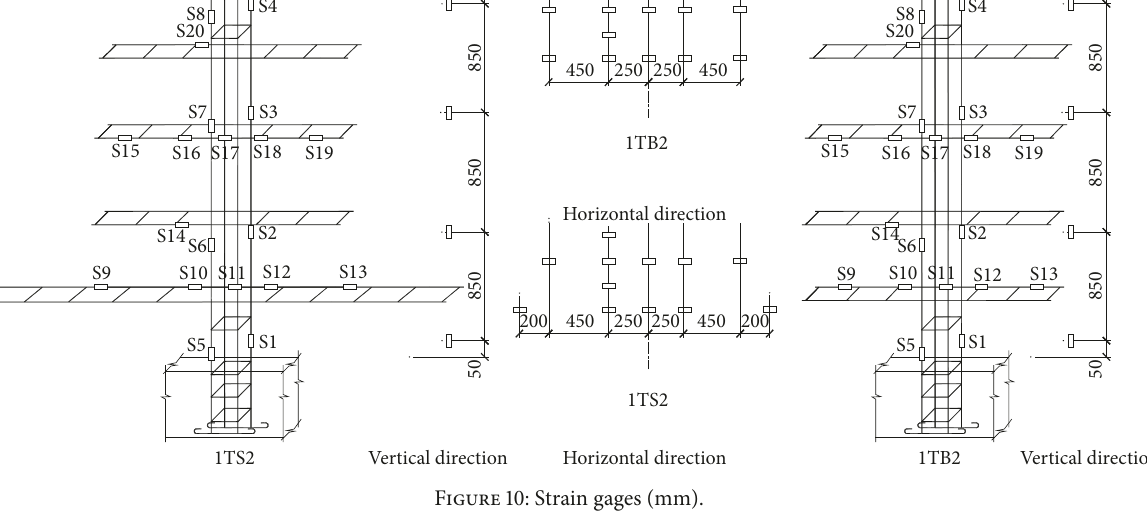
Figure 10: Strain gages (mm).